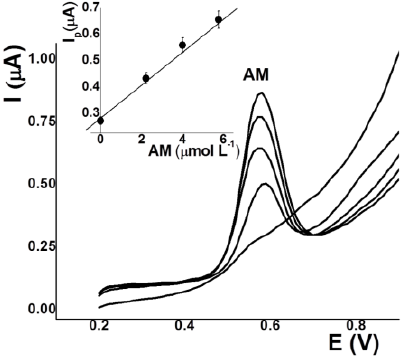
Figure 6. AdSV and calibration curves (inset) of kola soft drink for AM analysis. Conditions: pH 3.2 (0.01 mol L −1 phosphate buffer), E ads 0.00 V, t ads 30 s.